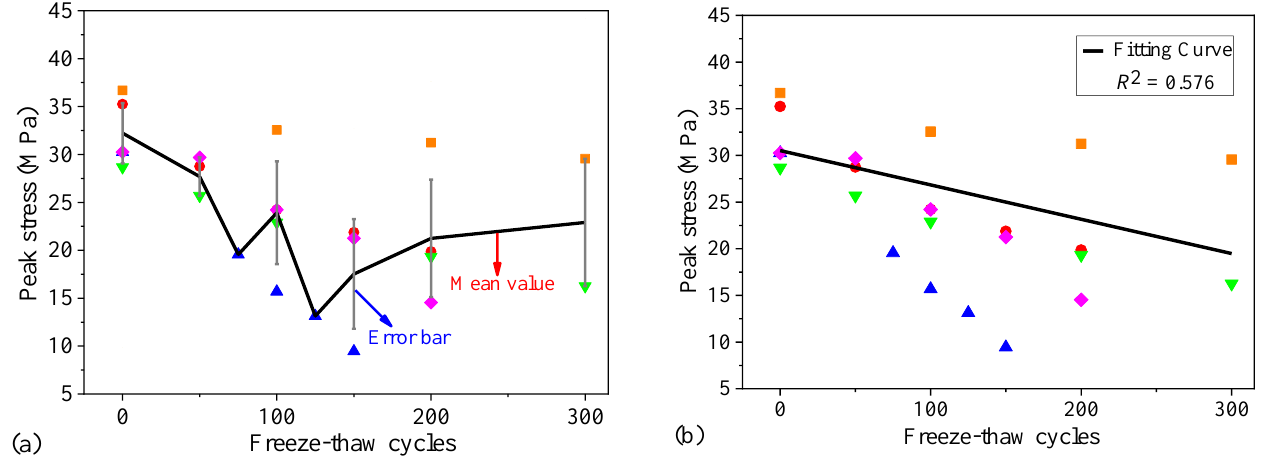
Figure 1. The peak stress test results of C30 concrete: ( a ) the mean value and error results and ( b ) the fitting curve. (Note: represents Gong et al. (2018) [10]; represents Niu et al. (2019) [21]; represents Duan et al. (2011) [22]; represents Sun et al. (2019) [23]; and represents Zhang et al. (2019) [14]).